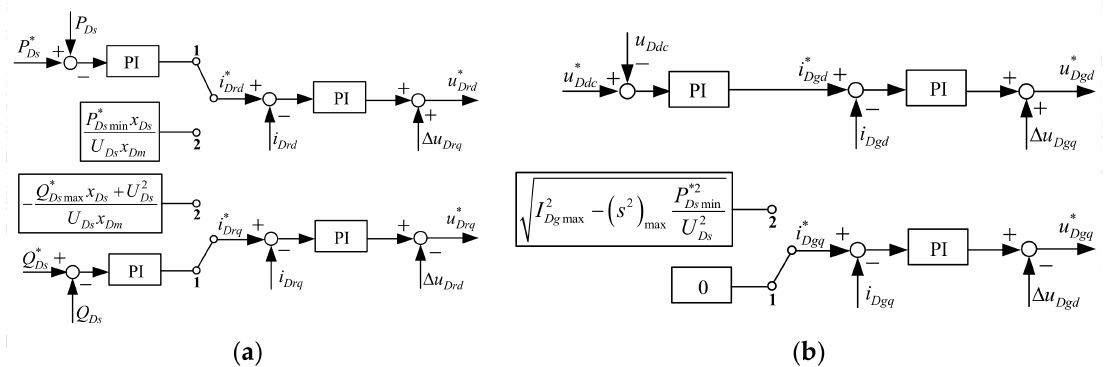
Figure 4. Control block of the method ( a ) Control block of the rotor-side converter (RSC); ( b ) Control block of the grid-side converter (GSC).